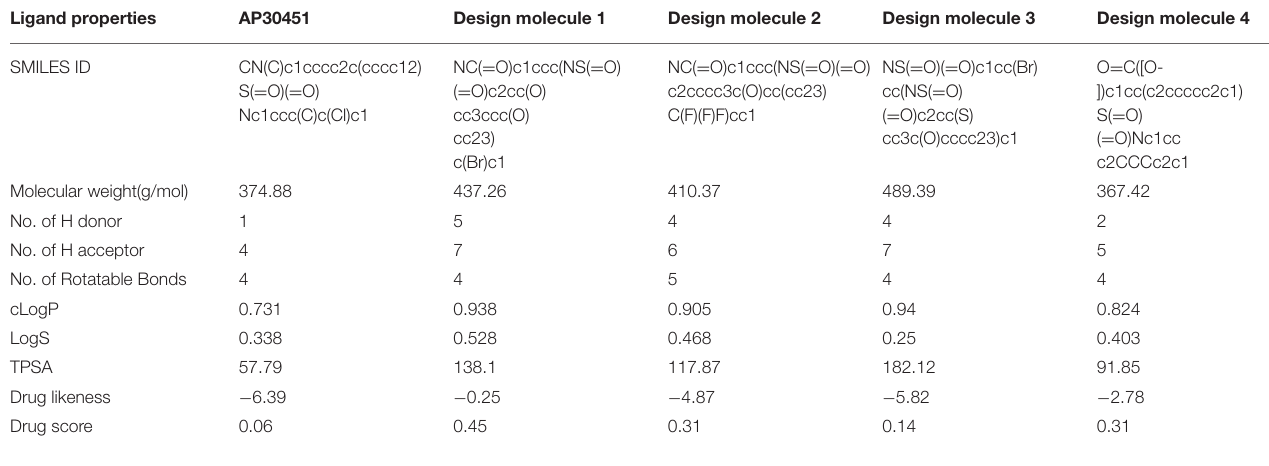
TABLE 3 | QSAR properties of control drug and proposed WNV